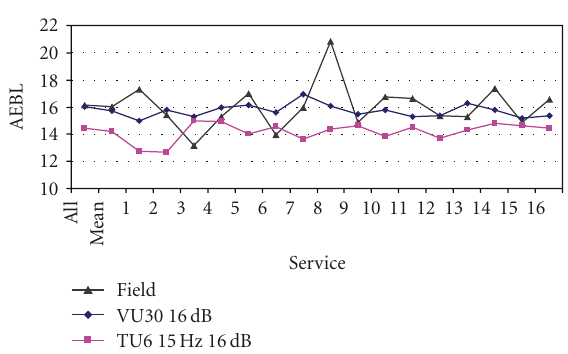
Figure 9: Average error burst length at TS level for the VU channel and TU6 15Hz channels at C/N = 16dB and in the field in a vehicular urban use case.